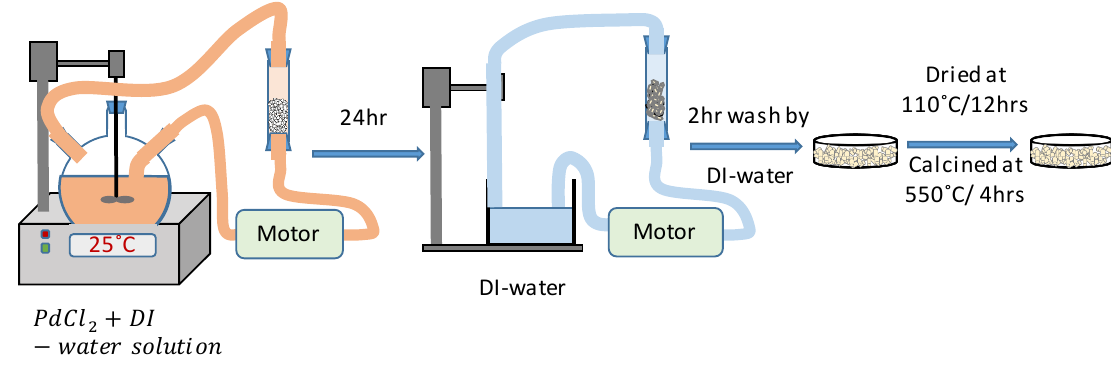
Figure 8. Catalyst preparation mechanism.